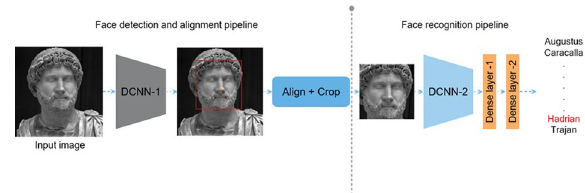
Fig. 3 Proposed imperial portrait recognition pipeline. Image of Hadrian: © Centre for Art Historical Documentation, Radboud University.